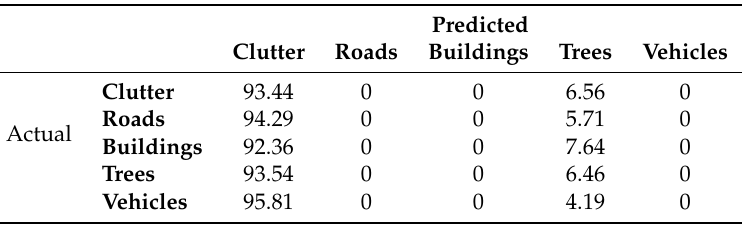
Table A5. Normalized confusion matrix for the GSCNN model that is trained on coordinates and colors, after 50 epochs.